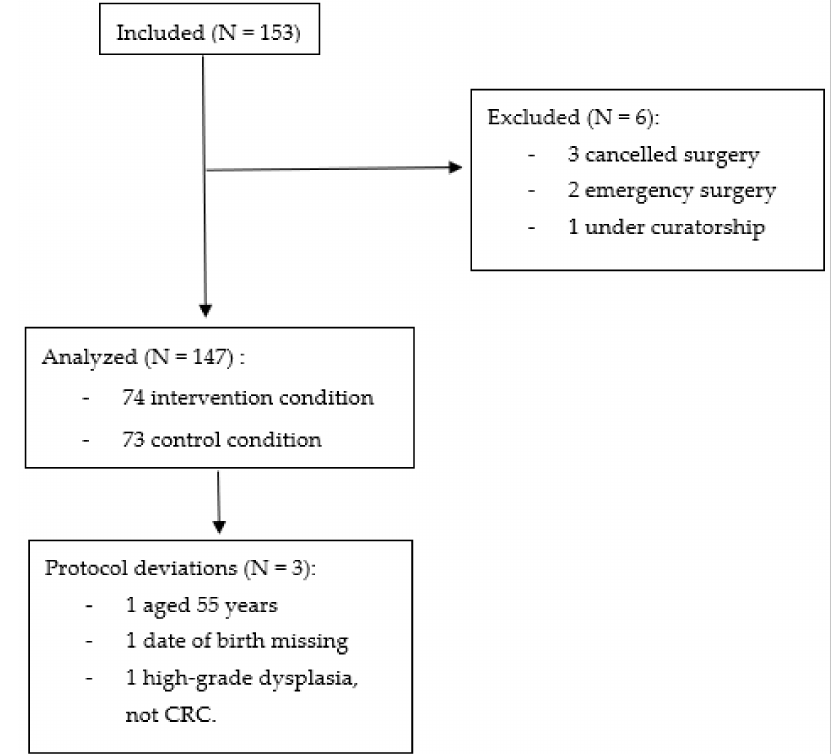
Figure 2. Study flow